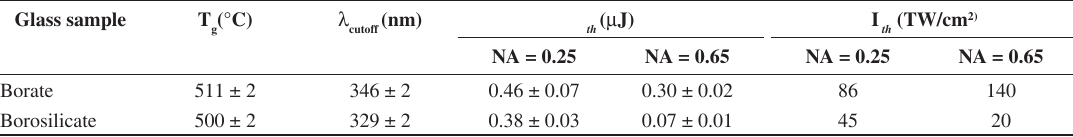
), cutoff wavelength ( λ g